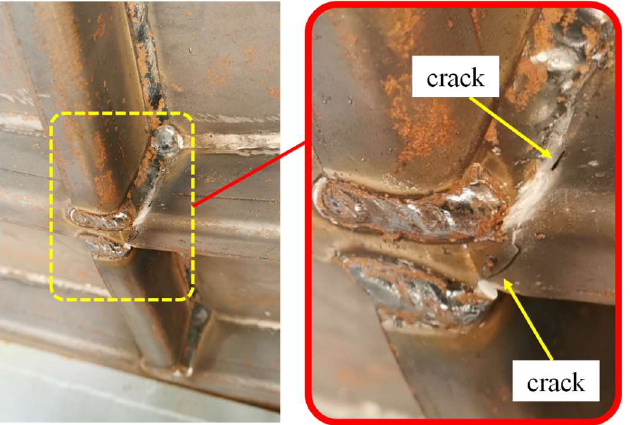
Figure 12. Fracture occurred at the cross joint of the stiffeners on the strengthened plate under cen- tric